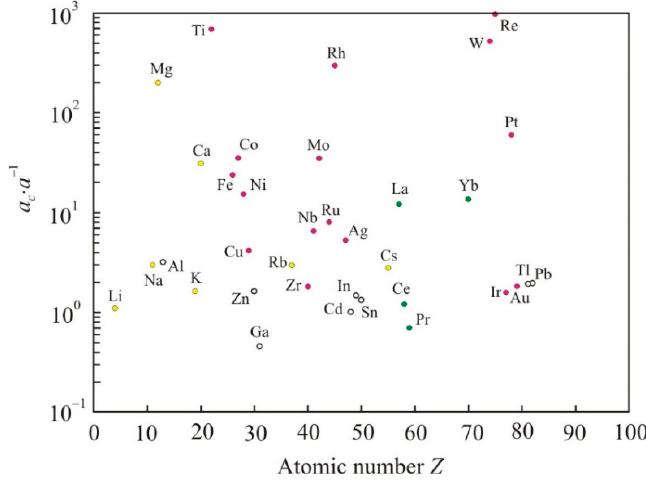
Figure 2. Ratio of the calculated cluster size to the atomic size a c / a for liquid metals at the melting point.